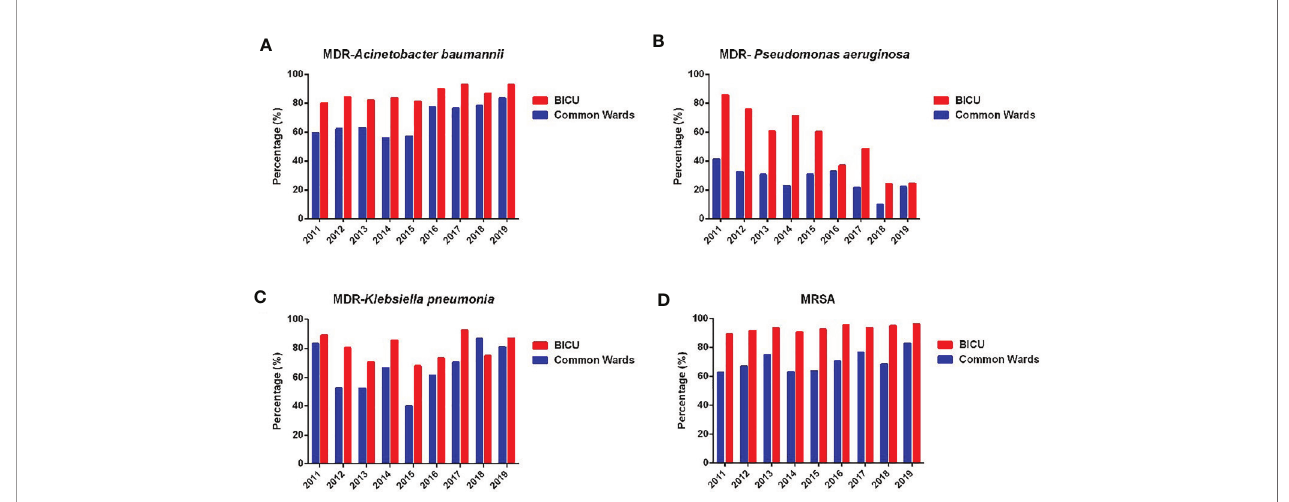
FIGURE 4 | Annual changes of MDR of common bacteria. (A) Annual distribution of MDR of Acinetobacter baumannii from BICU and BCW. (B) Annual distribution of MDR of Pseudomonas aeruginosa from BICU and BCW. (C) Annual distribution of MDR of Klebsiella pneumonia from BICU and BCW. (D) Annual distribution of MDR of MRSA from BICU and